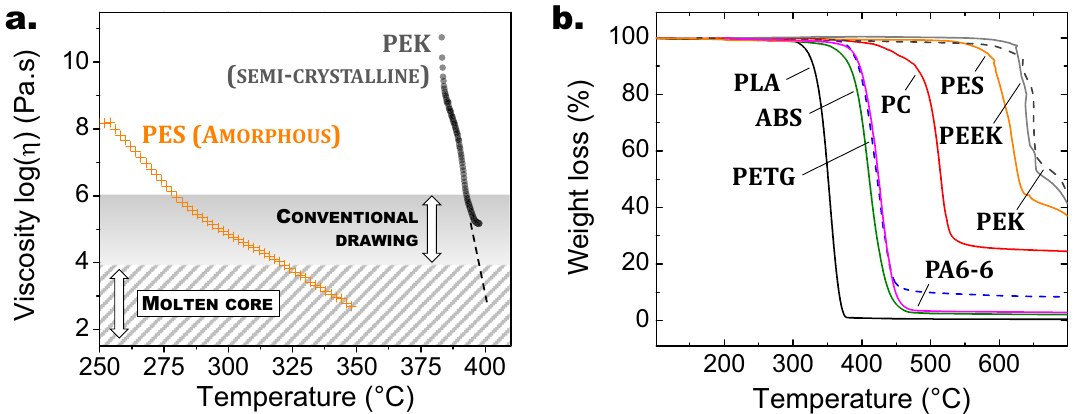
Figure 1. ( a ) Viscosity curves of amorphous polyether sulfone (PES) (orange symbols) and semi-crystalline polyether ketone (PEK) (black symbols). Viscosity ranges for the conventional fiber-drawing method (10 6 to 10 4 Pa s) and the molten core technique (η < 10 4 Pa.s) are displayed on the graph. ( b ) TGA curves of various amorphous or semi-crystalline thermoplastic polymers (see Table 1 for the meaning of the used